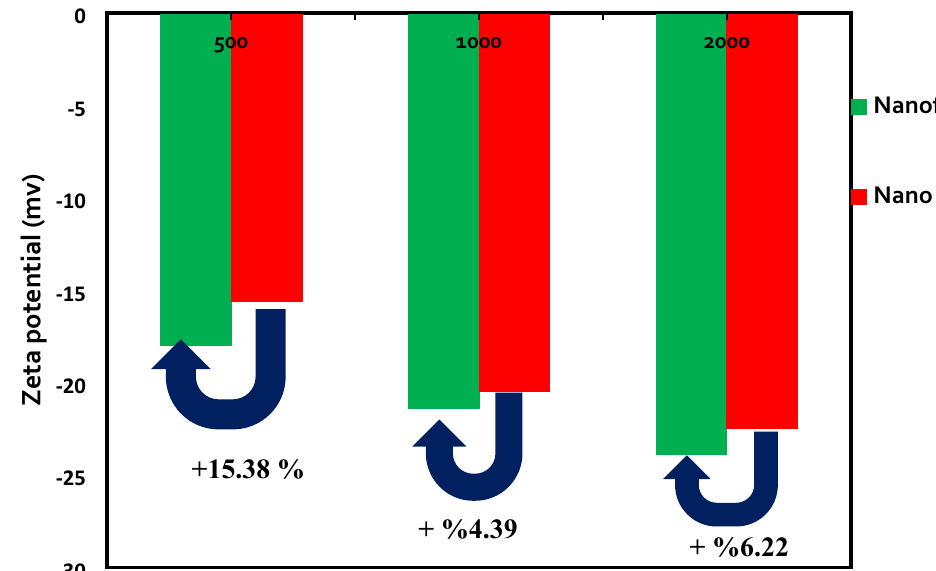
Figure 6. ZP vs. NPs concentration with various pH.